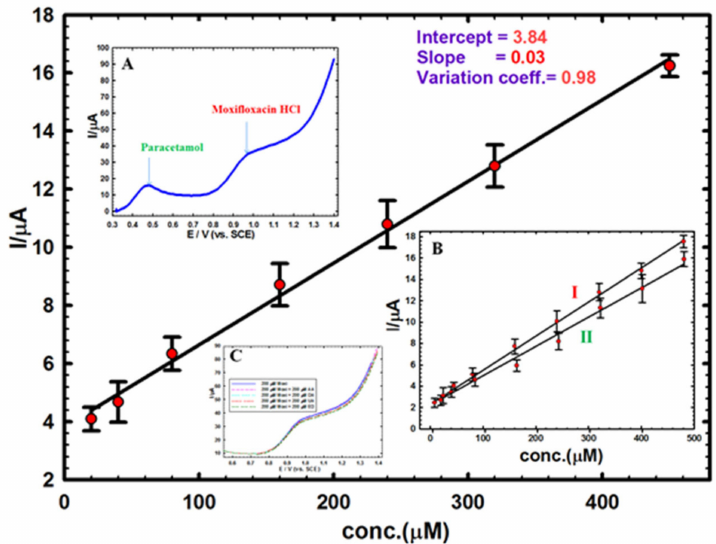
Figure 6. Calibration plot of Moxi in a urine sample prepared in B-R bu ff er solution (pH 7.0) using GNMSPE. Inset A: separate detection of 200 µ M Moxi with 200 µ M paracetamol by DPV in the same solution. Inset B: I) calibration plot for Moxi in the presence of 200 µ M paracetamol, and II) calibration for paracetamol in the presence of 200 µ M Moxi. Inset C: detection of 200 µ M Moxi alone or in the presence of 200 µ M ascorbic acid, dopamine, uric acid or estradiol). Table 2. Recovery and standard deviation data for Moxi detection in urine sample with GNMSPE. Spiked Moxi ( µ M) Detected Moxi 1 ( µ